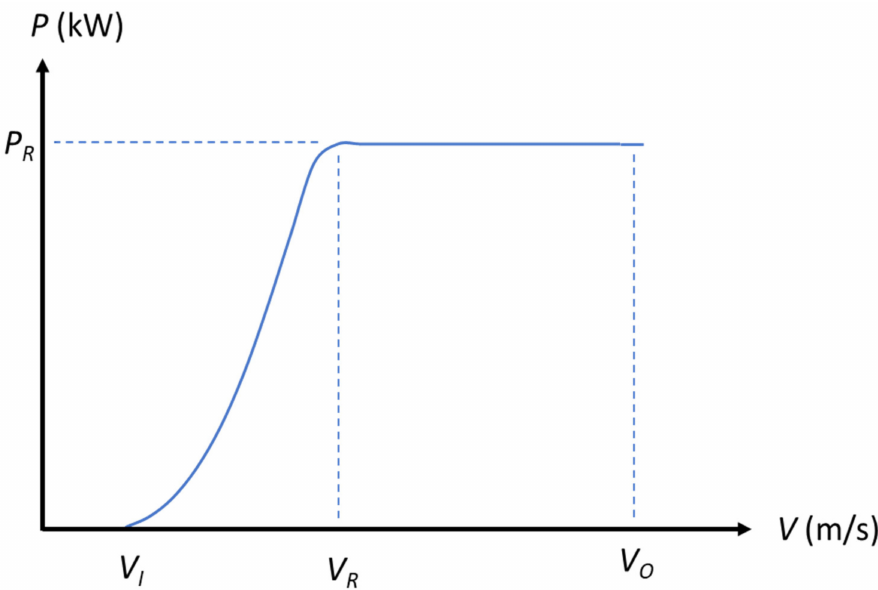
Figure 3. Generation of output electrical power of pitch-controlled wind